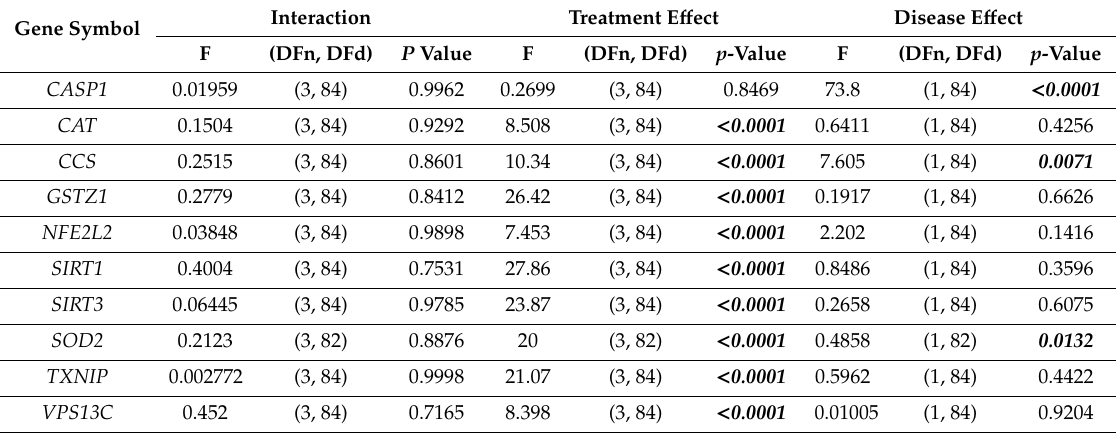
Table 3. Two-way ANOVA analysis of relative expression of candidate genes involved in aging and oxidative stress in AD and HC lymphoblasts treated with di ff erent concentrations of resveratrol